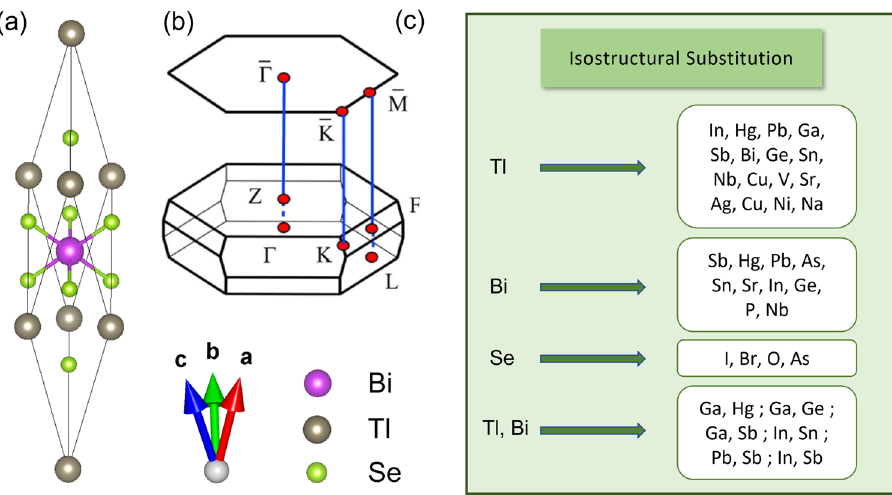
Figure 1. ( a ) Primitive crystal structure of TlBiSe 2 , ( b ) 3D BZ for primitive unit cell with four time-reversal invariant points Ŵ , Z, F and L along with the projected surface BZ, and ( c ) complete substitution with various elements at Tl, Bi, Se and Tl, Bi sites